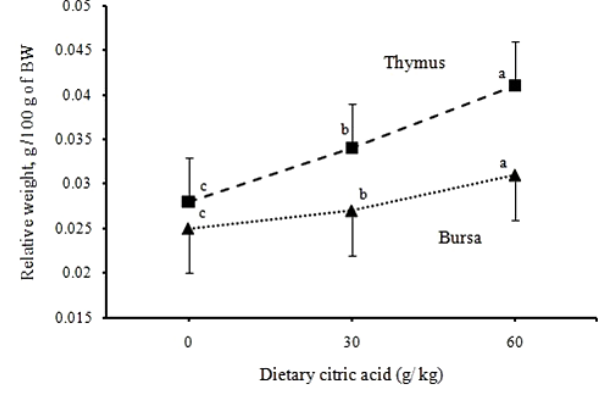
Figure 1. Relative weight of lymphoid organs (Bursa and Thy- mus) of 42-day-old broiler chickens by dietary inclusion of 30 and 60gkg − 1 of citric acid. Values are mean ± SE ( n = 5). Value is sig- nificantly different between control and dietary acidification groups ( P